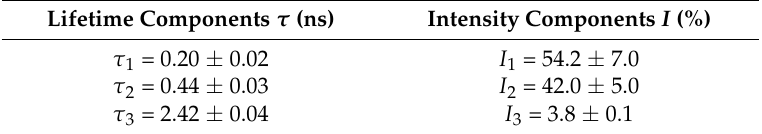
Table 1. Lifetime and intensity components obtained from the PALS spectra of